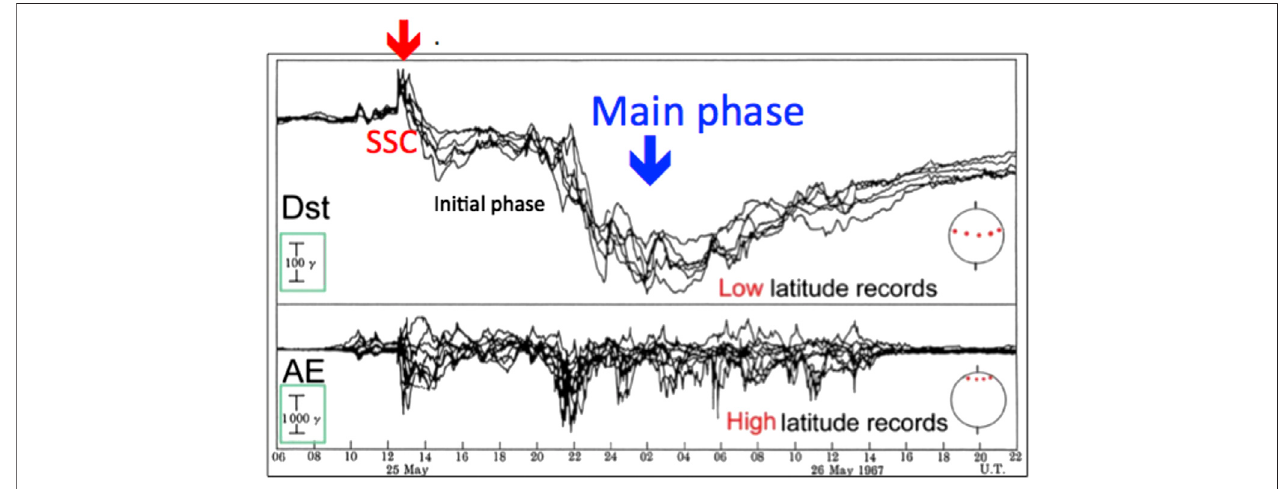
FIGURE 2 | An example of the standard type of geomagnetic storms, indicating the ssc, initial phase, and the main phase. The upper part combines records from sixstationsinlowlatitude.TheiraveragechangeiscalledtheDstindex. Thelowerpartcombinesrecords from12stationsinhighlatitude;theupperenvelopiscalledthe AU index, the lower envelope the AL index, and (Au + AL) the AE index. Note the difference of the scale between low latitude and high latitude. Unit γ (cid:1) nT.